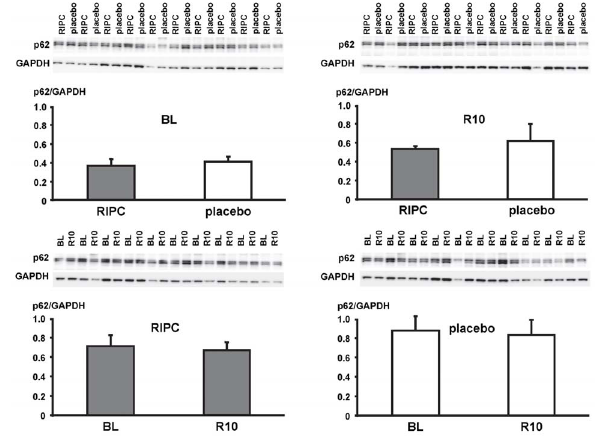
Figure 4. Expression of light chain 3 (LC3). Original Western blots of protein content of LC3 in myocardial biopsies obtained at baseline (BL) before initiation of cardiopulmonary bypass and at 5–10 min reperfusion (R10) from patients undergoing remote ischemic precon- ditioning (RIPC) or not (placebo). LC3-II (lower band) was normalized to glyceraldehyde 3-phosphate dehydrogenase (GAPDH) and LC3-I (upper band), respectively. Ratios are presented in bar graphs.